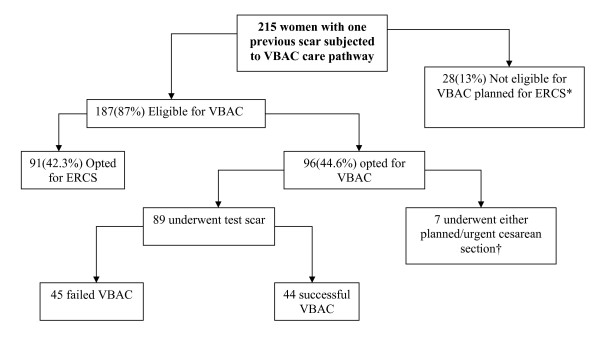
Management plan for women with one previous scar using the care pathway. * Postdatism; 11, Absolute CPD; 3, Medical complications requiring induction of labour (hypertensive disease; 3, Gestational diabetes; 2, PMTCT for HIV; 3), Persistent breech presentation; 4, Suspected macrosomia; 1, Previous myomectomy; 1.†Prelabour rupture of membranes requiring induction;4, Gave up test of scar after having initially agreed for VBAC; 1, Undiagnosed breech in labour; 1, Compound presentation in early labour; 1.